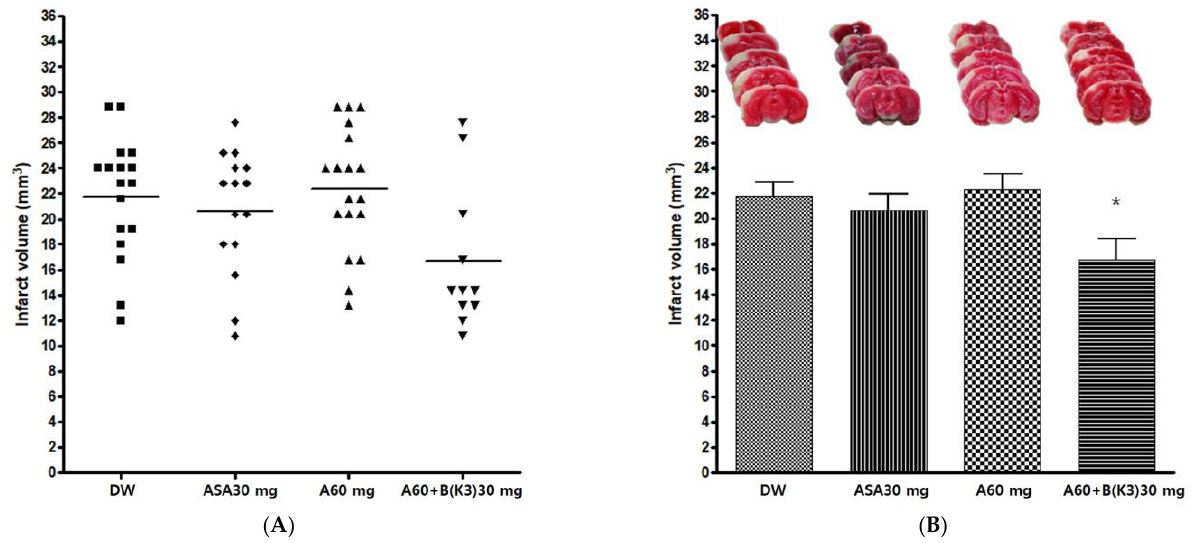
Figure 6. Effects of experimental drug A60+B(K3) 30 mg/kg on ischemic brain injury after permanent middle cerebral artery occlusion (pMCAO). Infarct volume was measured 24 h after pMCAO. DW and all drugs were administered just before pMCAO. ( A ) Individual infarct volume values for each group (n = 15 – 19 mice for each group). ( B Upper ) Representative photographs of infarcted brain slices from DW- and drug-treated mice. ( B Lower ) The group administered the experimental drug A+BK3 exhibited a significant decrease in infarct volume after pMCAO compared to the A60 group. DW, distilled water; ASA, Aspirin ® ; A, Ethanol extract of Coptidis Rhizoma, Phellodendri Cortex, Scutellariae Radix, Gardeniae Fructus, and Rhei Rhizoma; B(K3), Ethanol extract of 2020 Korean Salviae miltiorrhizae Radix and Notoginseng Radix. Data represent means ± standard deviation. * p < 0.05 vs. A60 by analysis of variance followed by Tukey’s test.